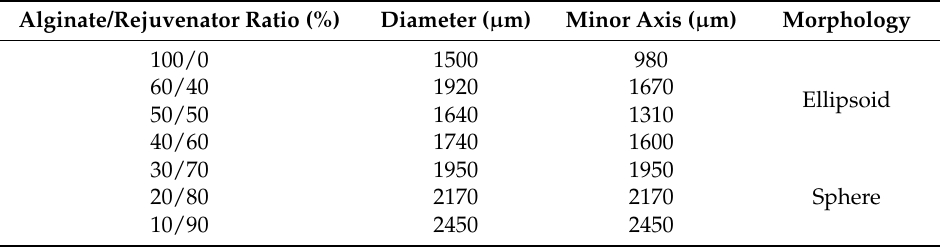
Table 2. Calcium alginate capsules with different alginate/rejuvenator ratios.